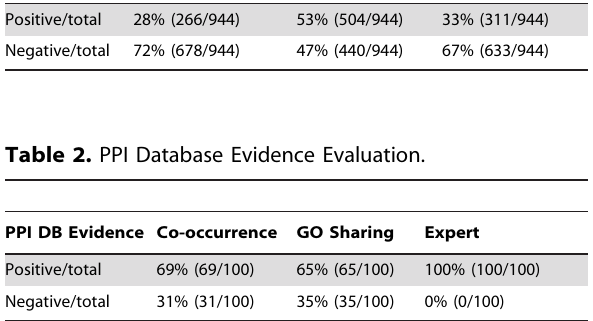
Table 1. Co-occurrence Evaluation.